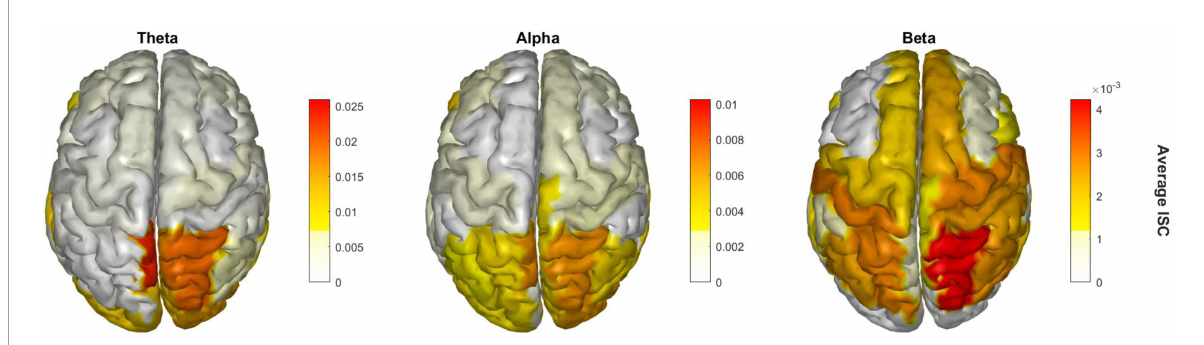
FIGURE4 Significant brain regions of ISC during the peak time window across the three frequency